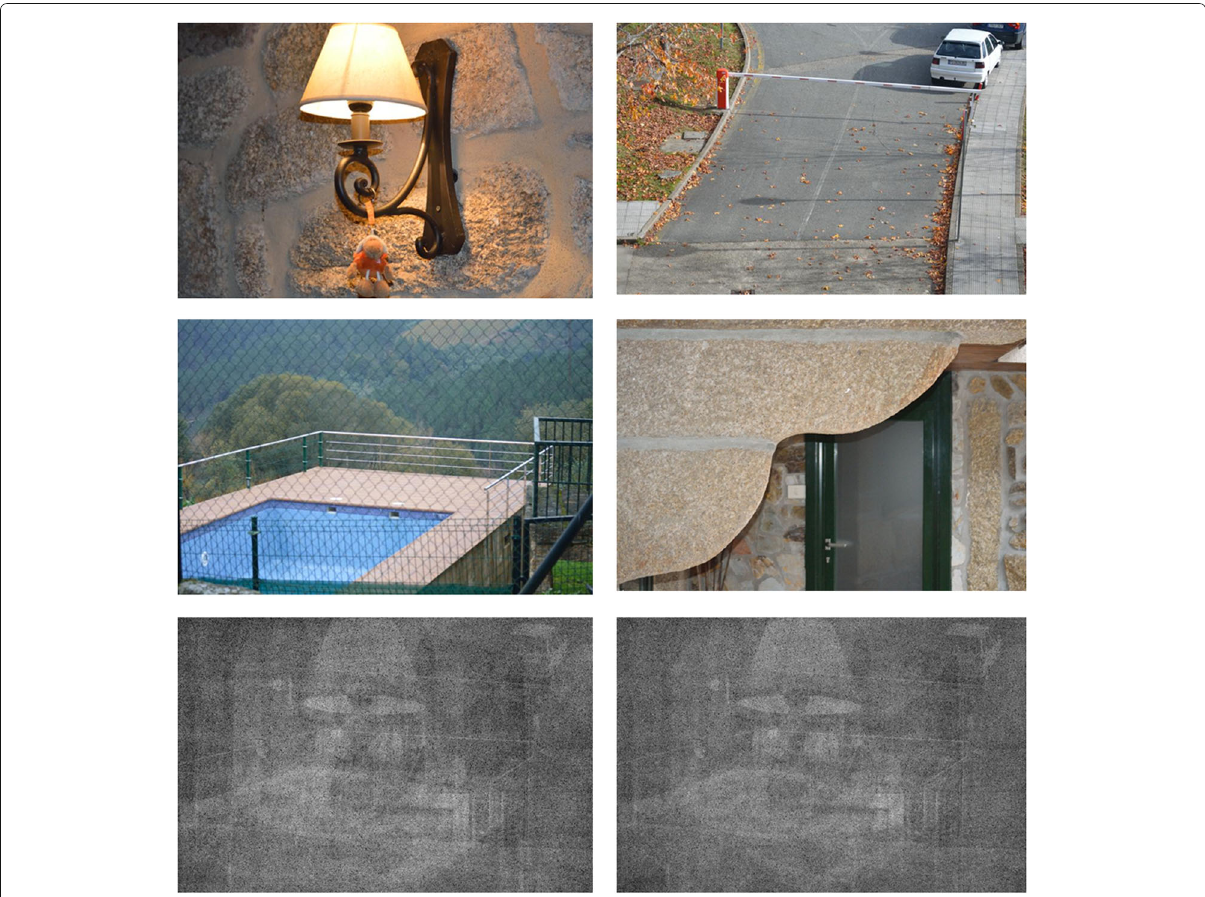
Fig. 3 Several images taken with the NikonD3200 camera from the dataset. Bottom panels: emphasized local variance of the corresponding estimated PRNU computed using a window of size 9 × 9, (left): extraction using the wavelet denoiser, (right): extraction using the BM3D denoiser